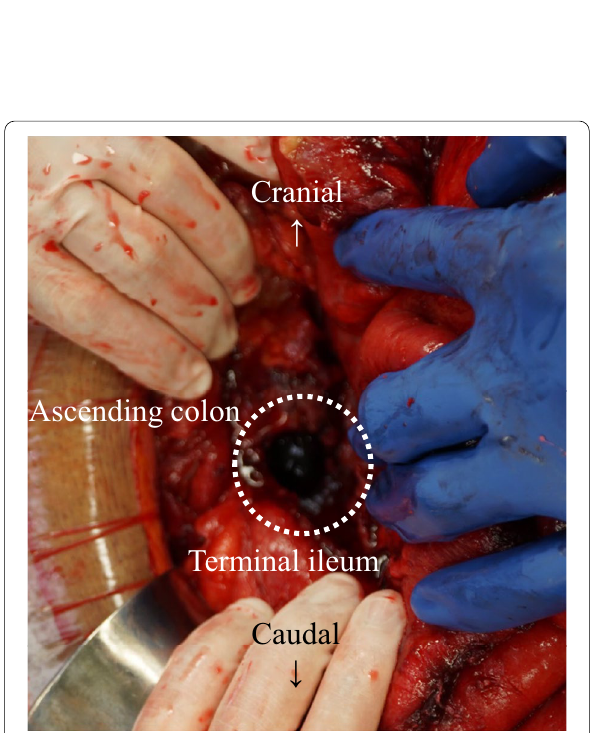
Fig. 6 Intra-operative findings, showing the collapsed mesenteric hematoma (round), with adherence to the small